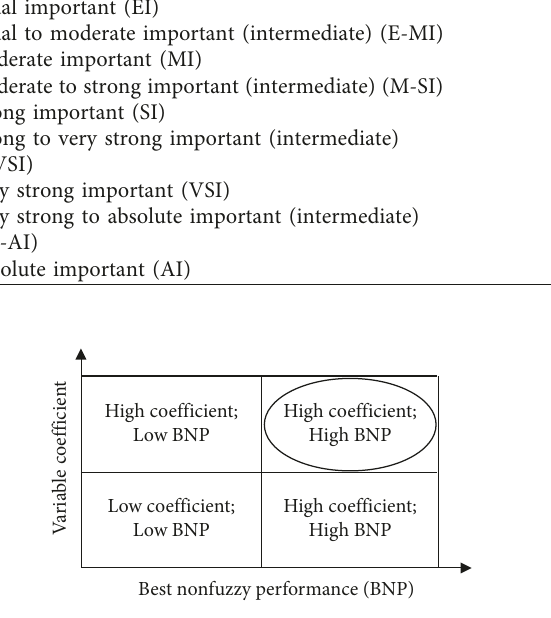
Figure 3: Input variable selection to meet the dual objectives of PCE. Table 2: Identified input